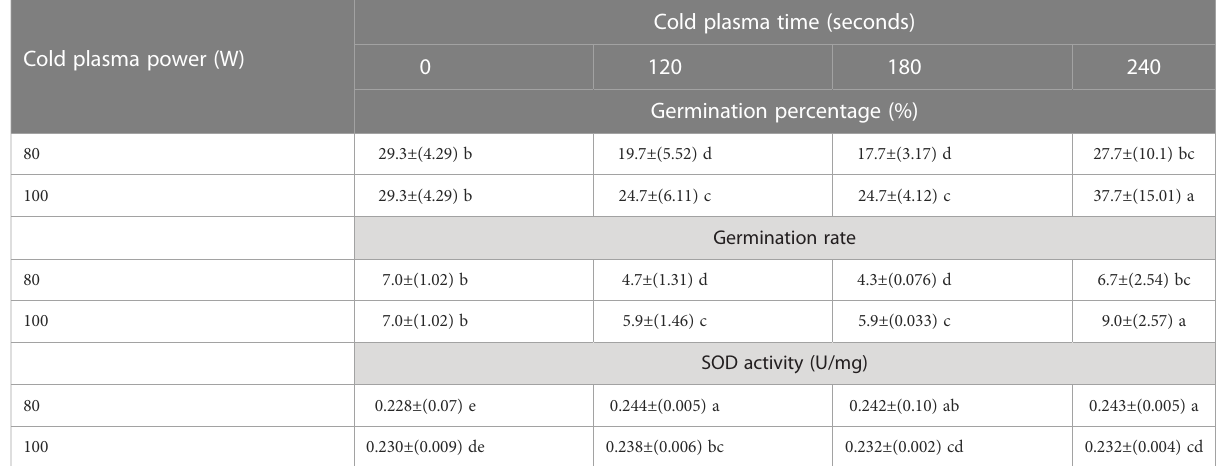
Values represent mean ± S.E. Different letters indicate signi fi cant differences at the 5% level according to the LSD test. LSD, least signi fi cant difference; SOD, superoxide